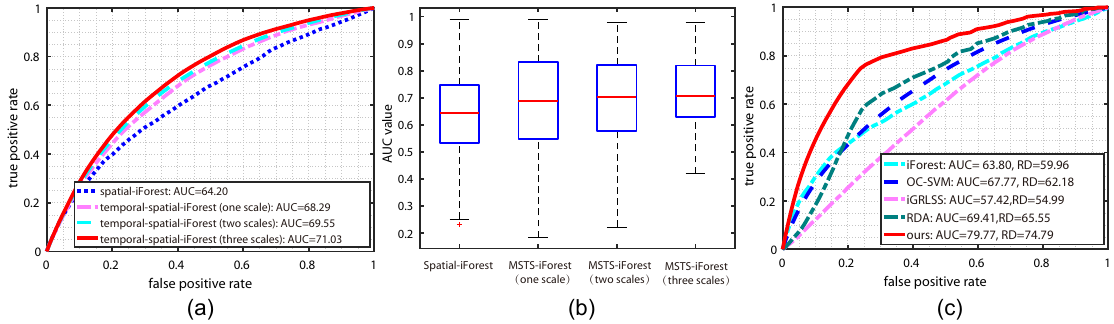
Figure 7. The performance comparison. ( a ) represents the pixel-level ROC curves and the average AUC values (%) of iForest and MSTS-iForest, ( b ) denotes the dispersion degree of the AUC values on all the clips, and ( c ) is the pixel-level ROC curves of various anomaly